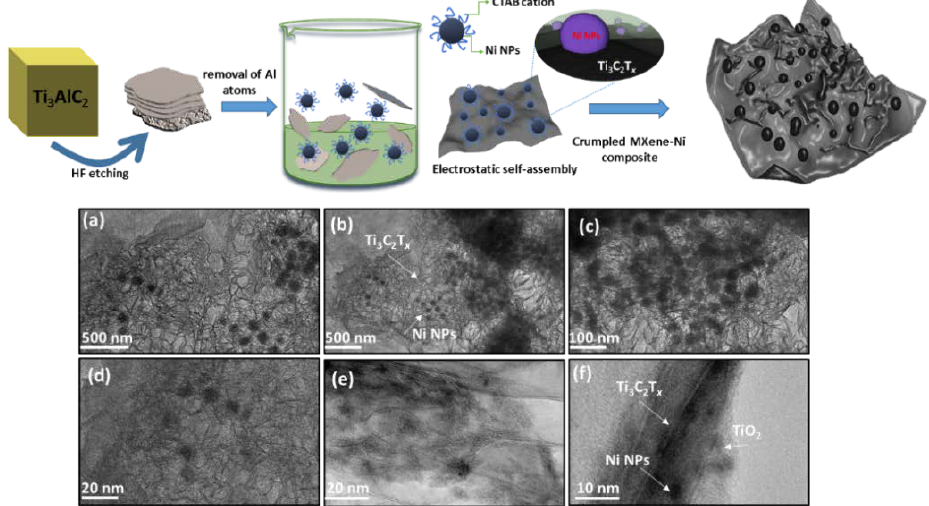
Figure 1. General schematic illustrating the self-assembly based formation of MX − Ni composites; ( a – e ) TEM images depicting Ni NPs loaded MXene cluster-like architectures with ( f ) focused TEM image showing the compact interfacial arrangement between Ti 3 C 2 T x , Ni and Ti 3 C 2 T x derived TiO 2 particles.